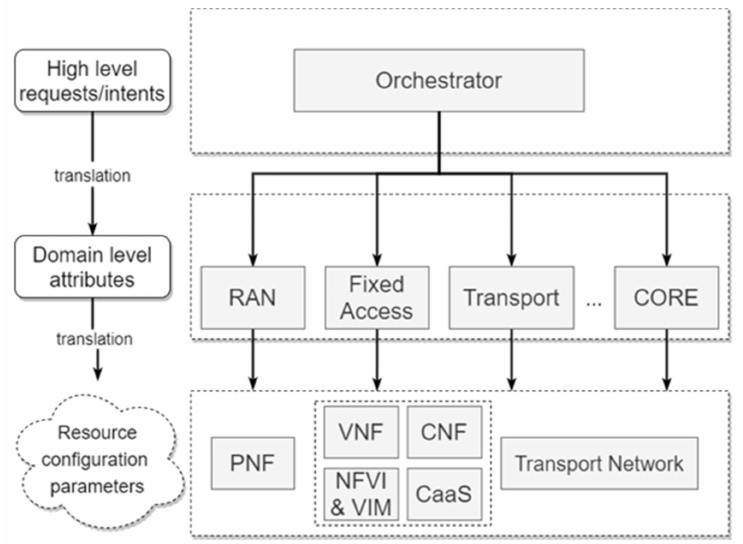
Figure 1. Orchestration management hierarchy for 5G network